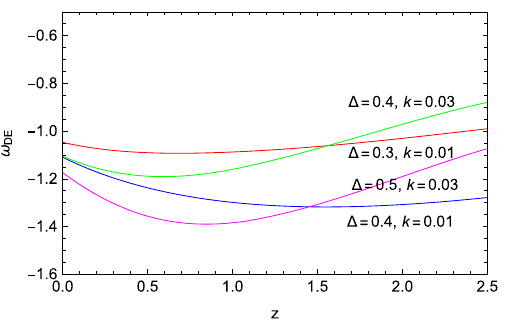
Fig. 5 Evolution of density parameter of matter and Barrow holo- graphic dark energy, as a function of redshift z , for C = 3 , in unit of M 2 p = 1. The lines corresponds: red: Δ = 0 . 3 and k = 0 . 01 ; blue: Δ = 0 . 4 and k = 0 . 01 ; green: Δ = 0 . 4 and k = 0 . 03 ; magenta: Δ = 0 . 5 and k = 0 . 03